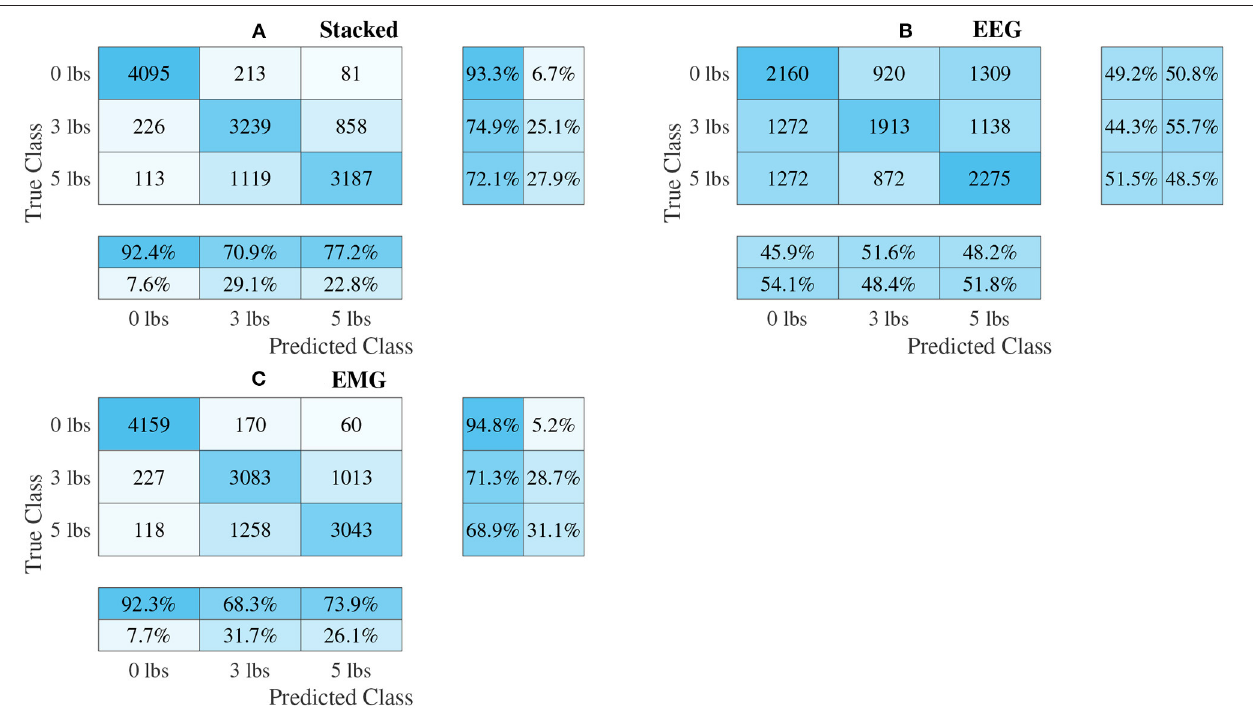
FIGURE 10 | Confusion matrices, using the combined classification results for all subjects, for the multi-channel spectrogram-based CNN models. (A) Shows the matrix for the stacked fusion method, while (B,C) how the matrices for the EEG and EMG only models, respectively. Each matrix contains a positive/negative precision score summary in the final two rows, and a positive/negative recall score summary in the final two